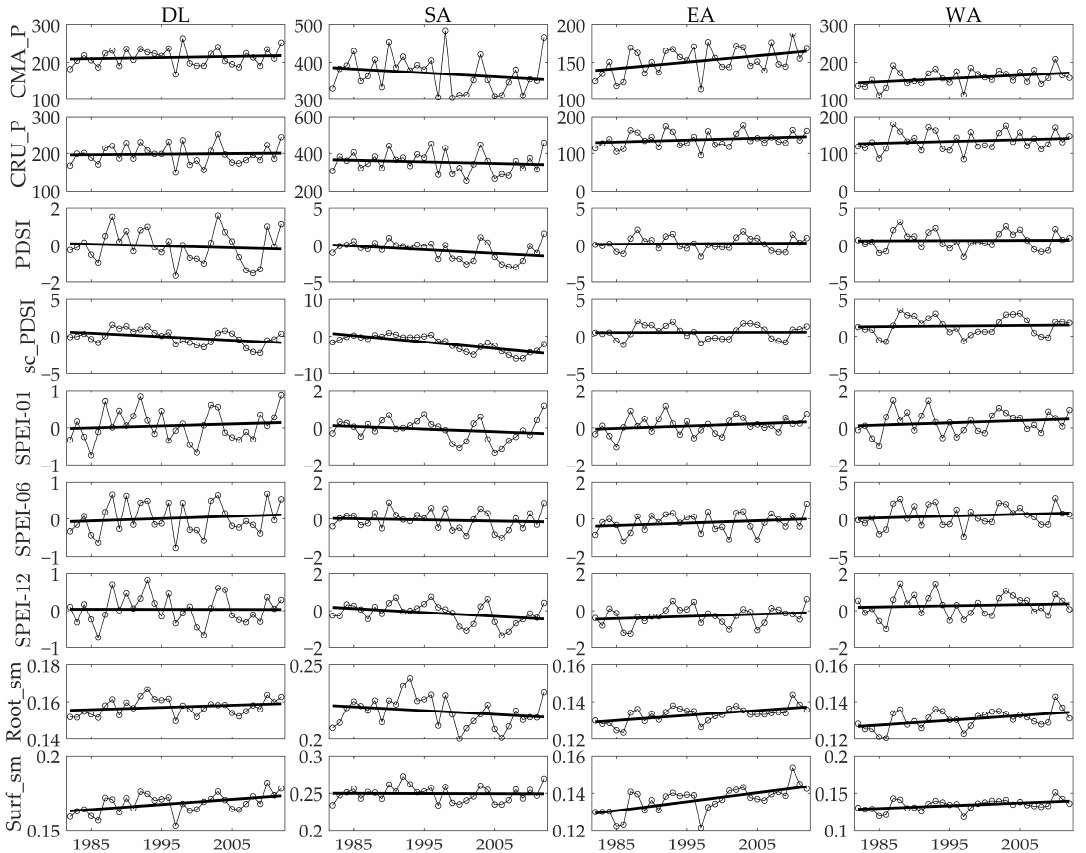
Figure 3. Interannual variation of nine dryness indications: precipitation (mm), PDSI, sc_PDSI, SPEI-01, SPEI-06, SPEI-12, Root_sm (m 3 m −3 ) and Surf_sm (m 3 m −3 ), in drylands and its three sub-regions, during 1982–2012. The solid lines indicate the linear fits during 1982–2012.